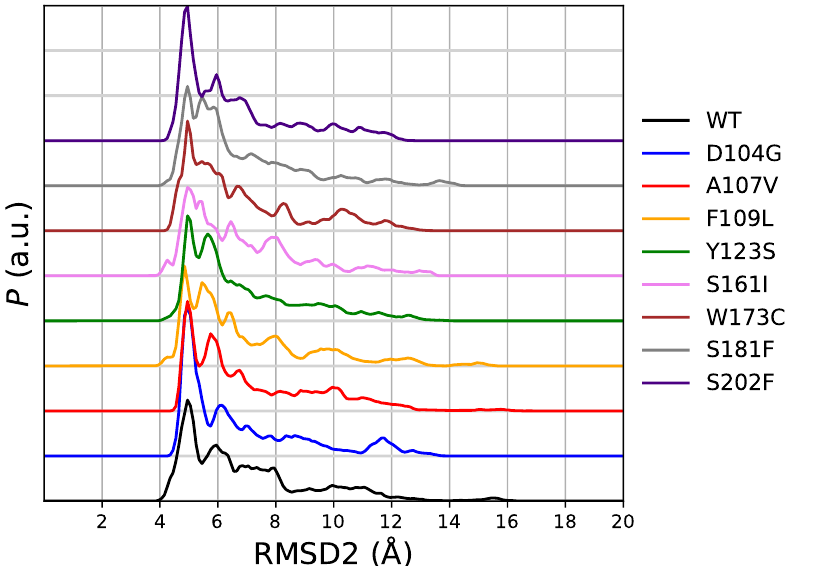
Figure 5. Distribution of root-mean square deviation with respect to PDB 5KZ5 (RMSD2) obtained in meta-statistics for all studied variants. The order is the same as for Figure 2.